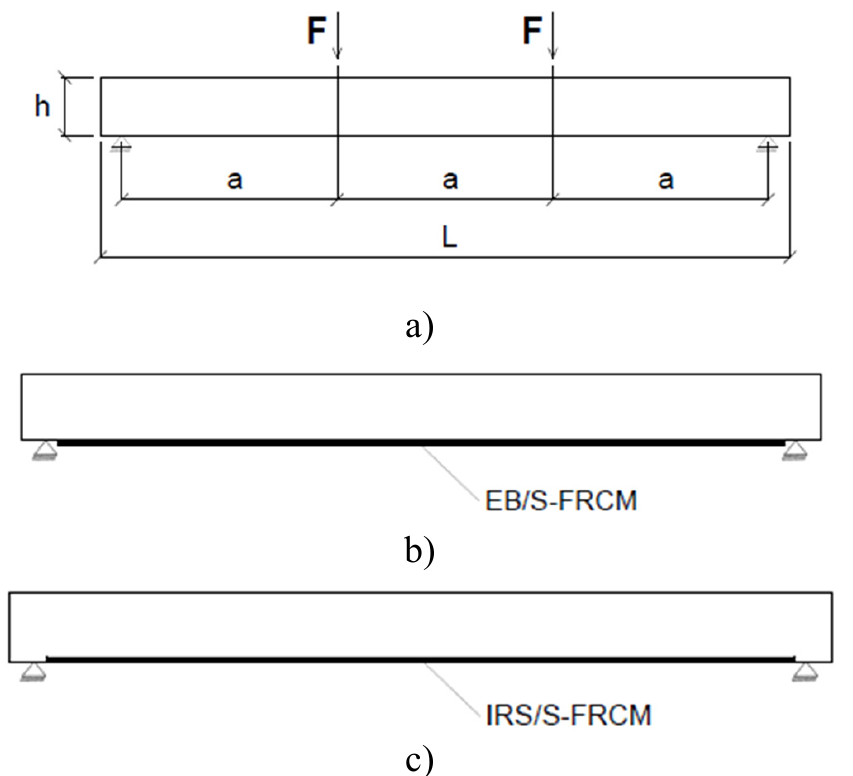
Figure 2. Geometry of control and strengthened beams: a) RC control beam; b) EB technique and c) IRS technique.